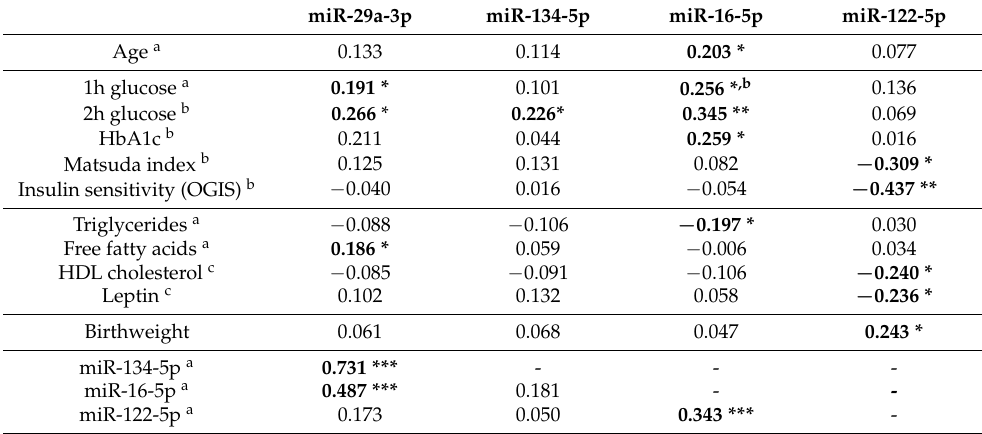
Table 2 Association between clinical variables and circulating miRNAs. Clinical variables were measured at baseline a , at 24–28 week b , or at 35–37 week c and correlated with baseline miRNA levels. Pearson correlation coefficients are listed. Statistically significant values are in bold with p values, * p < 0.05, ** p < 0.01 and *** p < 0.001. Levels of miRNAs were normalized against the geometric mean of snRNA U6, ath-miR-159 and c.el.miR-39 and logarithmic transformed prior to analysis. Covariate were maternal age and BMI, gestational age and offspring